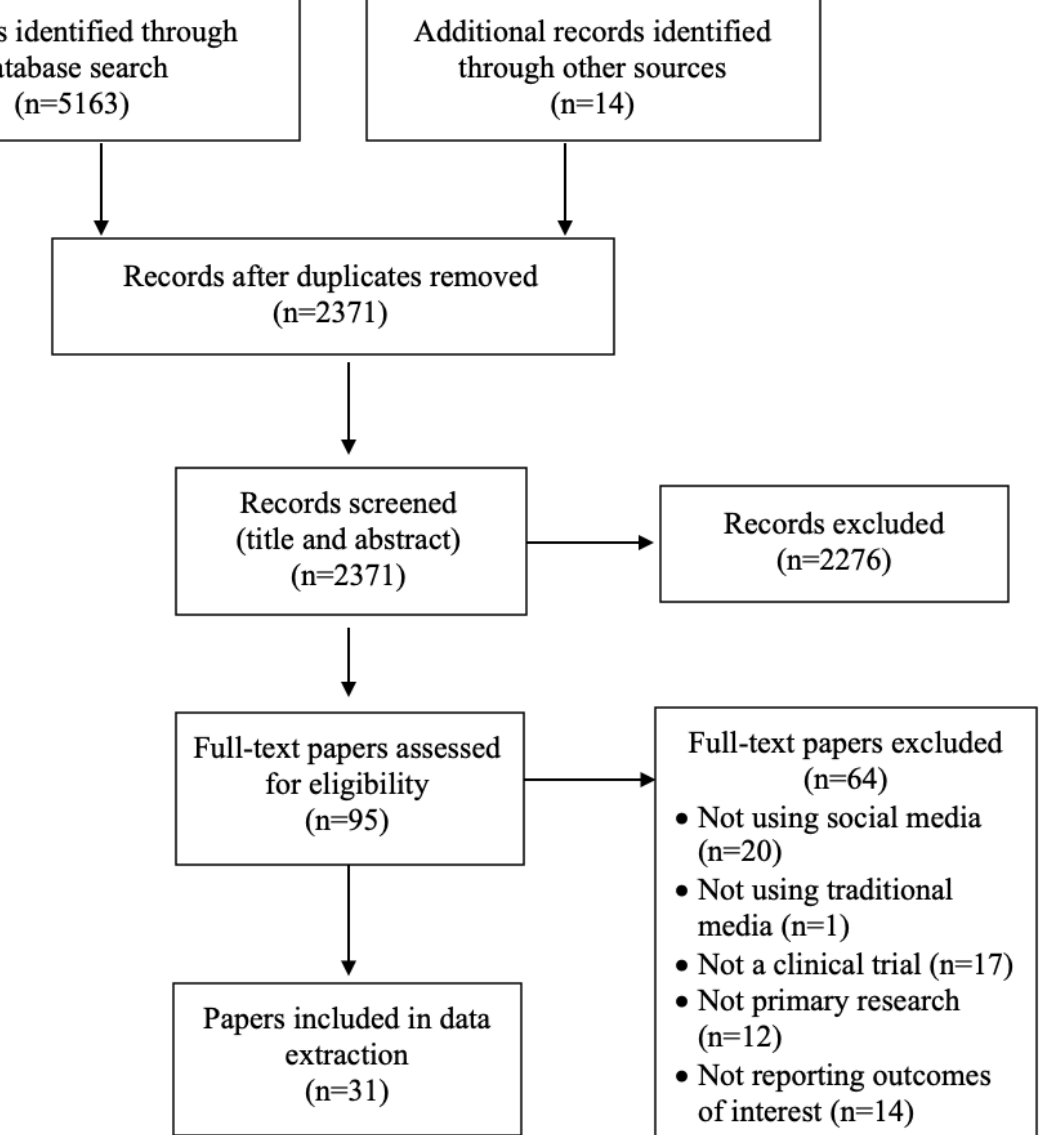
Figure 1. PRISMA flow